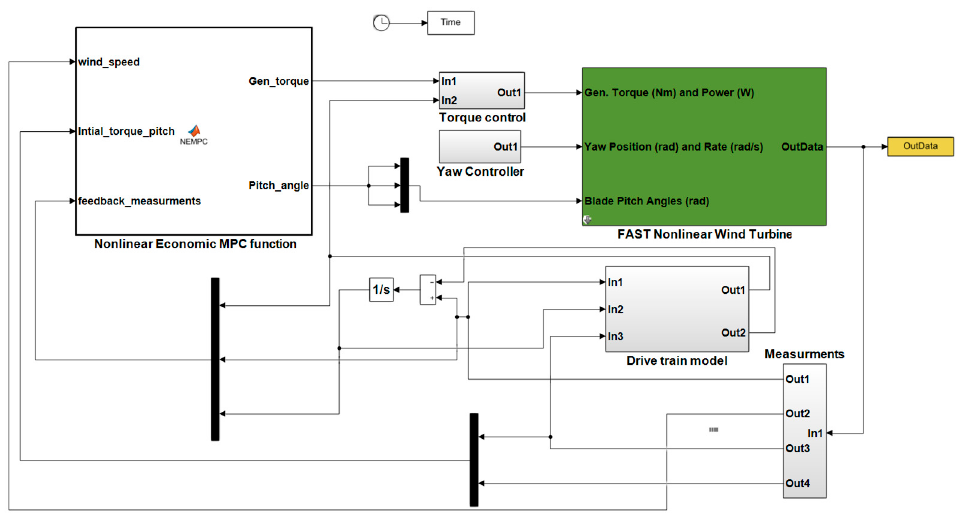
Figure 9. Simulation structure.